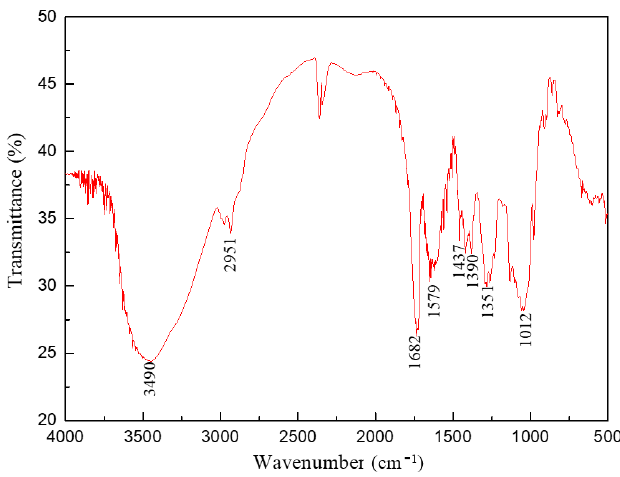
Figure 3. The FT-IR spectra of FLO-H.